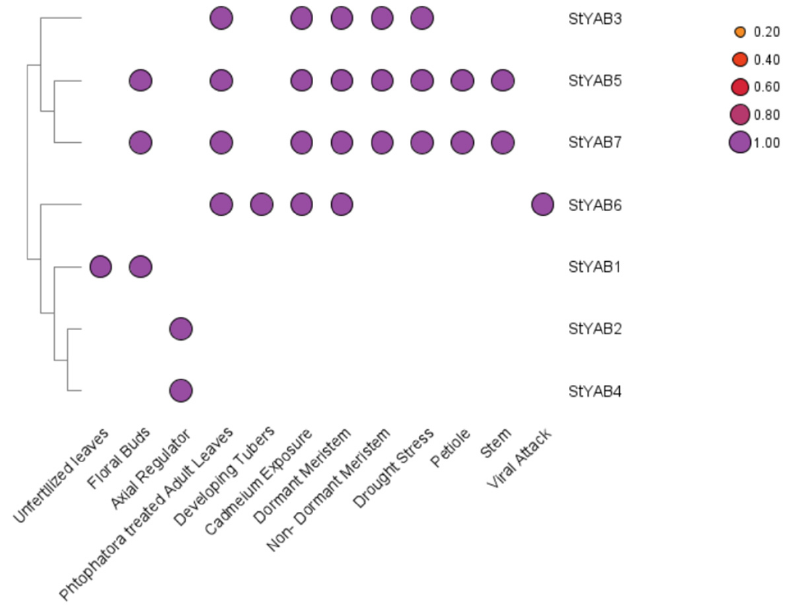
Figure 7. Heat map shows the expression profile of the StYAB genes in different organs and under different biological stresses of potato.